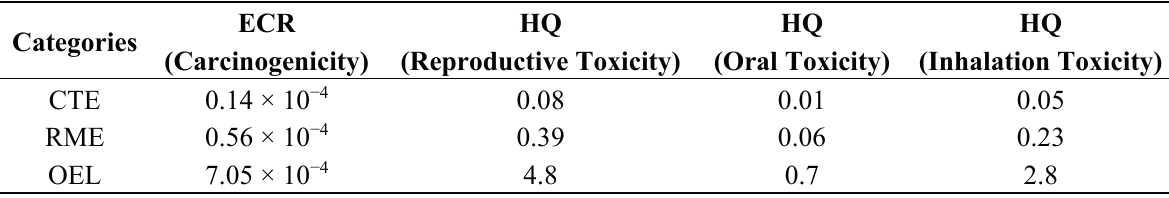
Table 5. Calculated risk values of